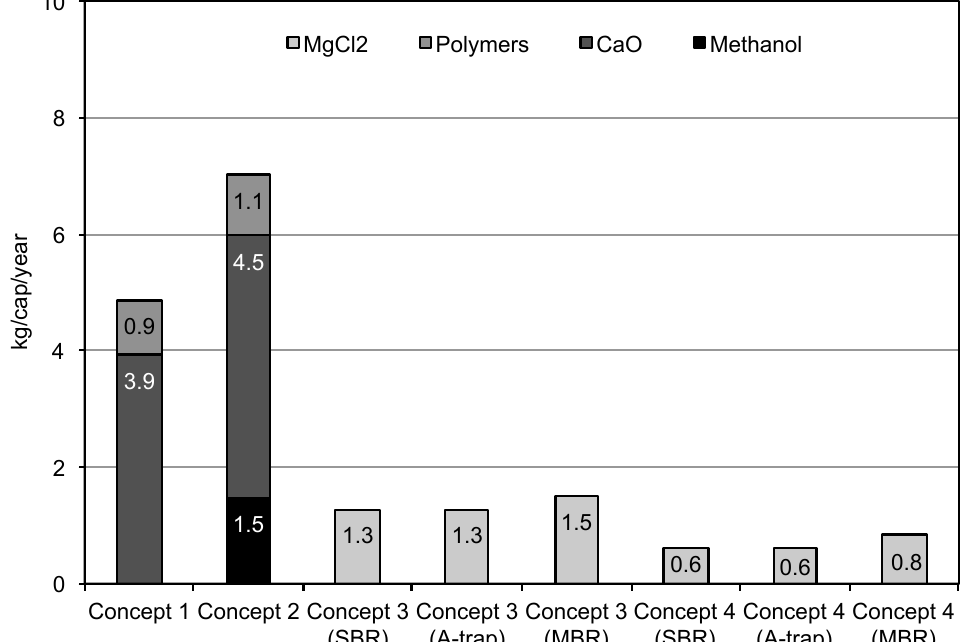
Figure 5. Chemical use in Concepts 1–4 with different grey water treatment